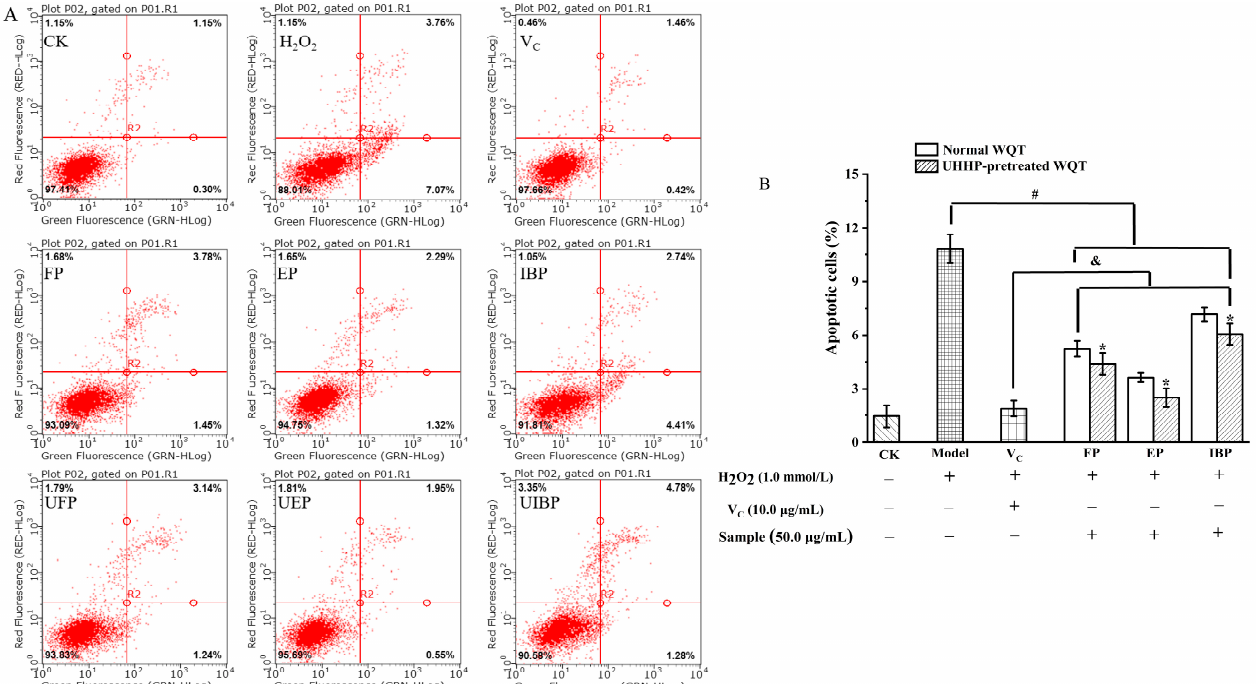
Figure 4. The inhibitory effects of the free, esterified, and insoluble-bound phenolic fractions from the normal and UHHP-pretreated White Que Zui tea (WQT) on apoptosis in H 2 O 2 -induced HepG2 cells. ( A ): flow cytometry analysis; ( B ): the apoptotic cell percentages of different groups. “*” indicated significant differences in the same fractions between the normal and UHHP-pretreated WQT ( p < 0.05); “#” indicated significant differences between the H 2 O 2 group and the sample groups ( p < 0.05); “&” indicated significant differences between the V C group and the sample groups ( p < 0.05). All the values are expressed as mean ± SD (n = 3). FP and UFP: free phenolic fraction from normal and UHHP-pretreated WQT; EP and UEP: esterified phenolic fraction from normal and UHHP-pretreated WQT; IBP and UIBP: insoluble-bound phenolic fraction from normal and UHHP-pretreated WQT.